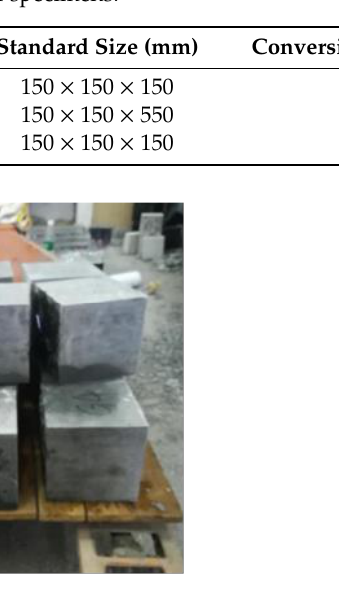
Figure 2. Concrete specimens for the compressive strength test.